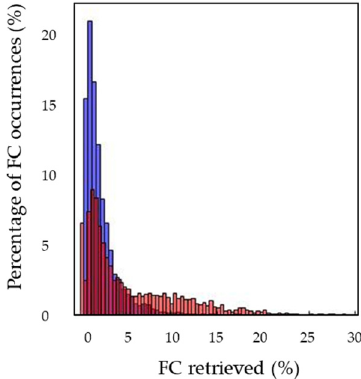
( b ) Figure 8. Spatial distribution of ( a ) FC (%) and ( b ) z retrieved by the SRT inversion method applied to the OLCI data acquired on 8 July, 2017, over the study area. Note that the data for which FC is lower than 0.1% and/or the depth is higher than 4.9 m were filtered out. About 80% of the retrieved depths are located between 1 m and the surface. The re- maining 20% left is then retrieved between 1 and 4.9 m. The greater depths (z > 1 m) seem to be retrieved on the edges of the aggregations while the shallow depths (z < 1 m) are observed in the center of the aggregations (Figure 8b). This could be explained by the fact that the abundance of Sargassum is lower on the edges of the aggregations, and thus the Sargassum buoyancy is decreased. The retrieval of FC is also performed using the δ MCI approach. Note that the values retrieved by such a method for which FC is lower than 0.1% were filtered out; thus, the isolated pixels are discarded to prevent false detections. The comparison between δ MCI and SRT inversion approaches is performed using a histogram (Figure 9). The histogram shows that FC values greater than 5% have more occurrences when using the SRT inver- sion (in red in Figure 9) than when using the δ MCI approach (in blue in Figure 9). On the contrary, the FC values lower than 5% have more occurrences when using the δ MCI ap-